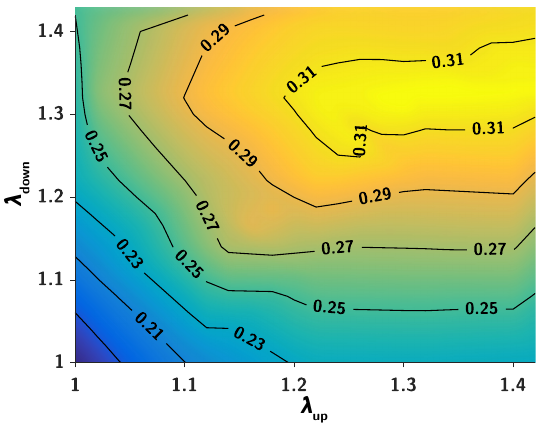
Fig. 9. Results for a sweep of tip-speed ratios for two turbines operating under constant angular velocity uncoordinated control at the optimal relative position identified previously ( y/D = − 0 . 81 ). The upstream and downstream turbine turbine tip-speed ratios are on the X and Y axes respectively. Contour lines indicate array performance, Eq.